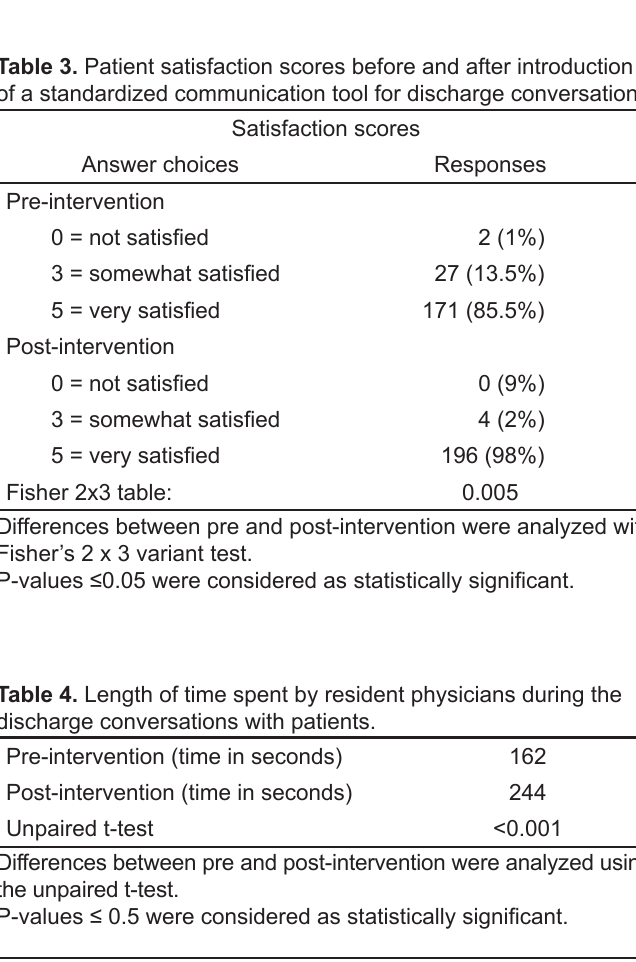
Table 3. Patient satisfaction scores before and after introduction of a standardized communication tool for discharge conversations.